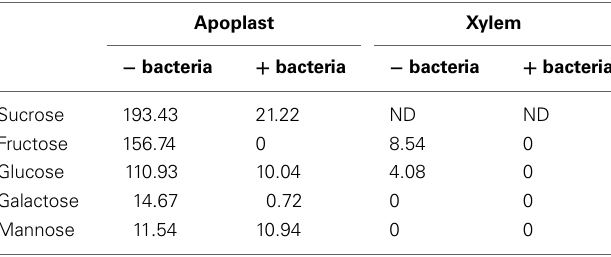
Table 1 | Sugar content in tomato exudates before and after growth of R.